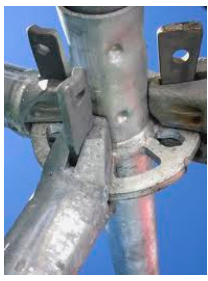
Figure 3. Joining element of multidirectional scaffolding [10].